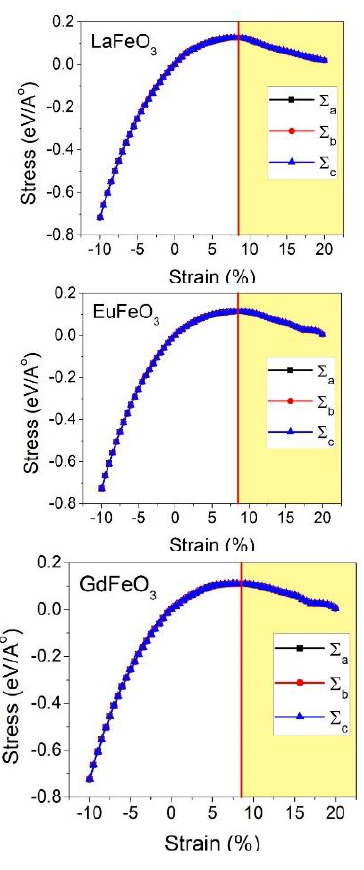
Figure 4. Stress–strain responses of LaFeO 3 , EuFeO 3 , and GdFeO 3 under cubic